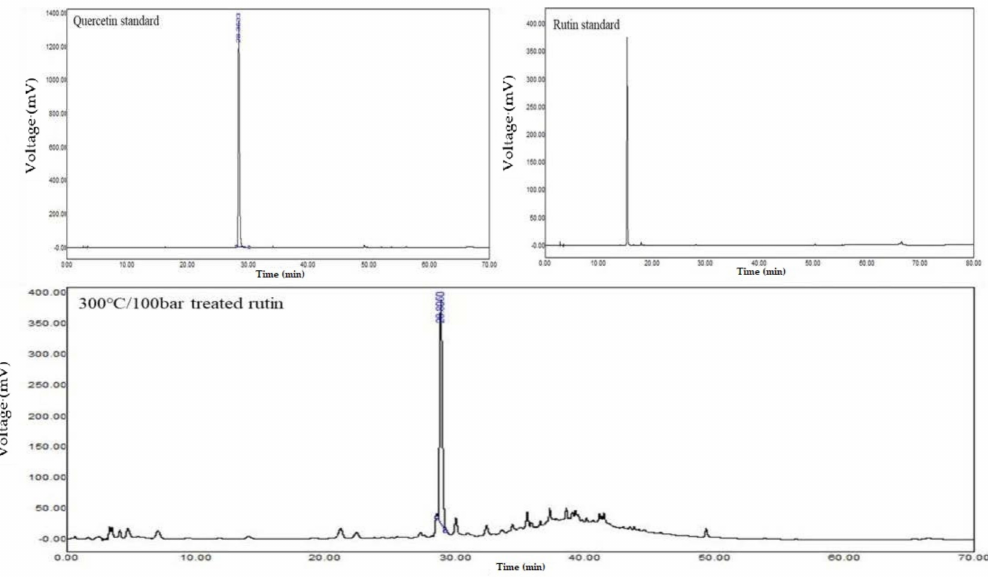
Figure 1. Chromatogram of rutin and quercetin standard and 300 ◦ C/100 bar treated rutin